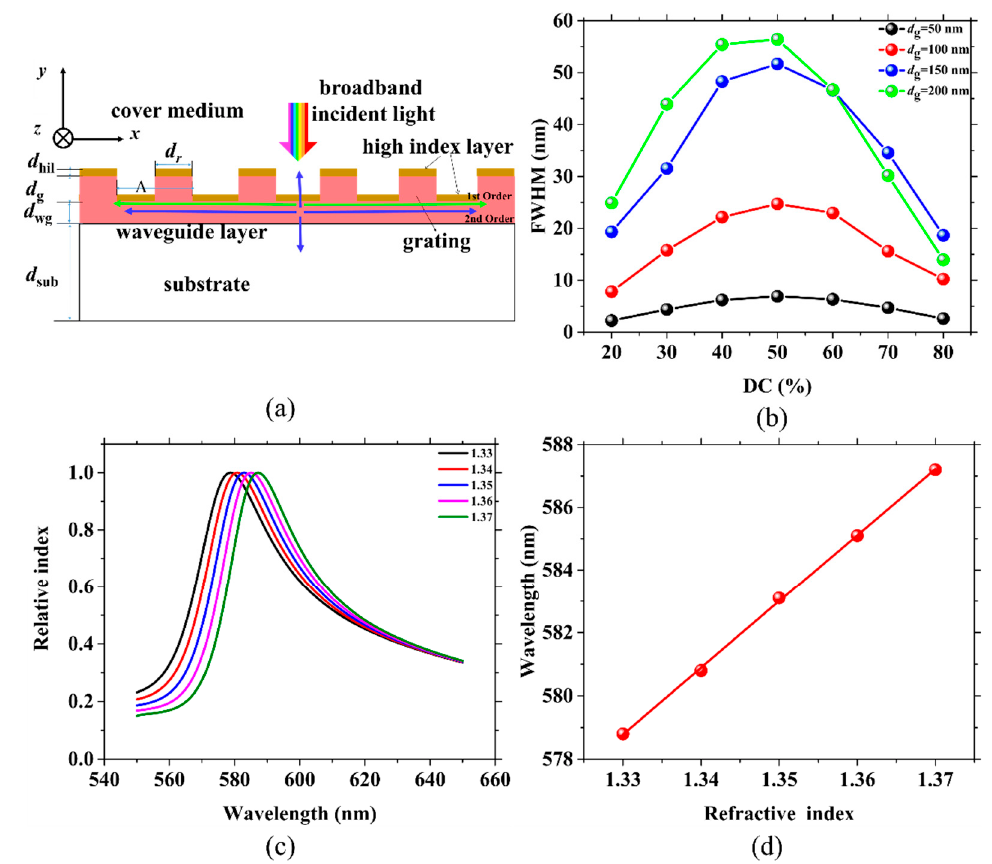
Figure 1. ( a ) Schematic structure of the passive grating sensors for wavelength shift detection. ( b ) The full width at half maximum (FWHM) for various groove depths ( d g ) and duty cycles (DCs); the same colored points represent identical values of d g ; the d g values are 50, 100, 150 and 200 nm. ( c ) An example of a resonant wavelength shift corresponding to a change in the index of refraction of the liquid medium ( n c ). ( d ) The linear fitting between the resonant wavelength ( λ peak ) and n c in (c). DC = 60%, and the thicknesses of the waveguide layer ( d wg ) and d g are 0 and 200 nm, respectively.